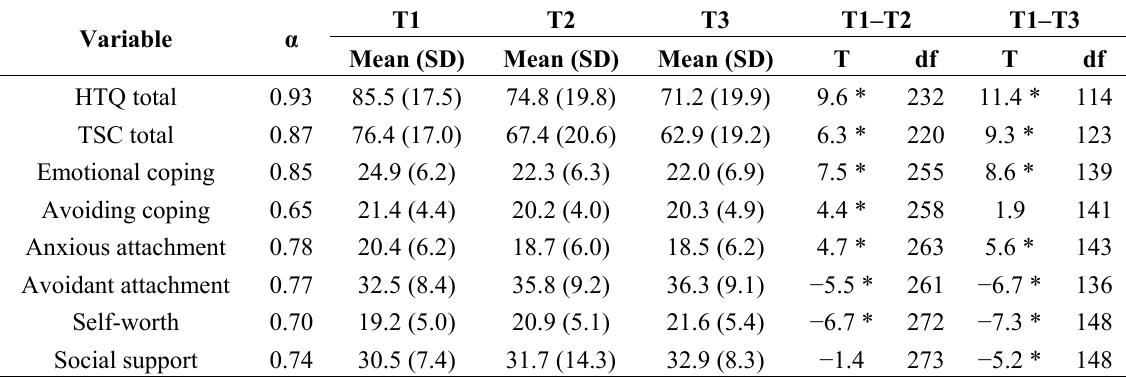
Table 2. Changes in psychological variables during 12 months of